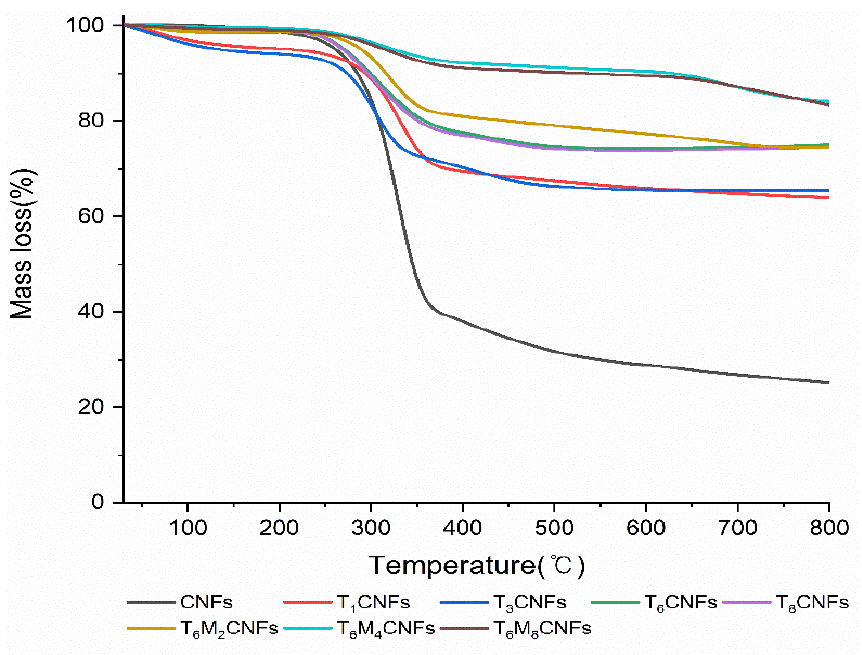
Figure 4. TGA curve of the silica surface modified CNFs (TnMnCNFs means applied reaction times of core–shell synthesis and CH 3 end capping).